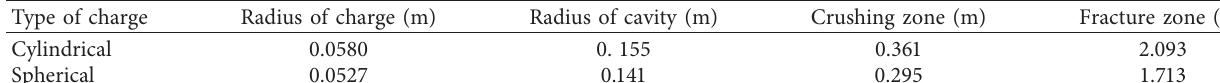
Table 3: Contrast of damage zones between spherical and cylindrical charges.